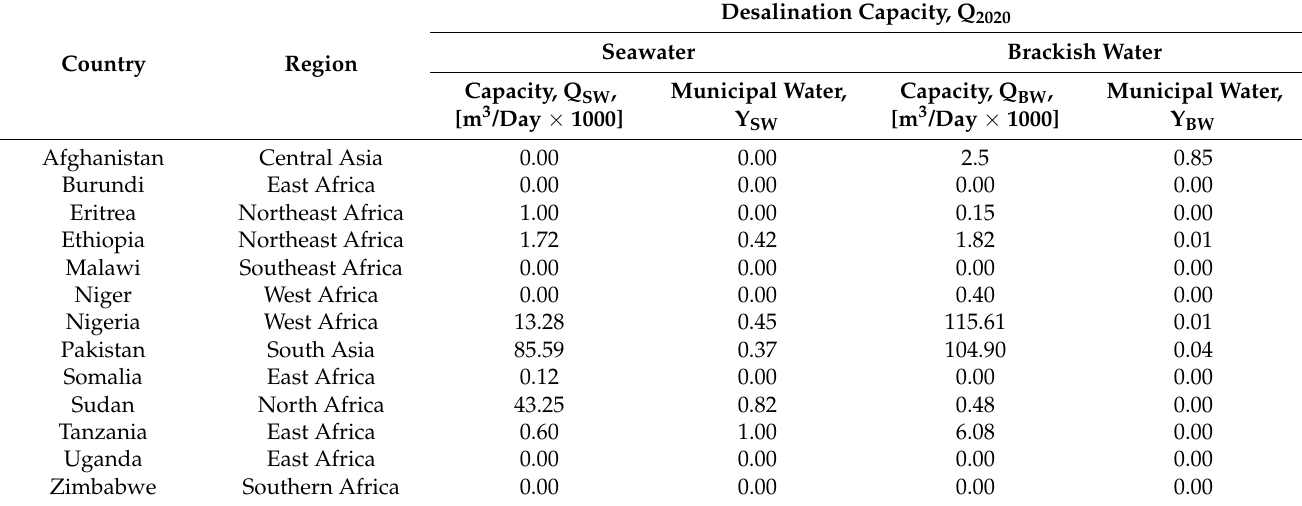
Table 1. Currently installed desalination capacity (sea and brackish water) in the chosen water-scarce countries and its share of municipal and domestic supply